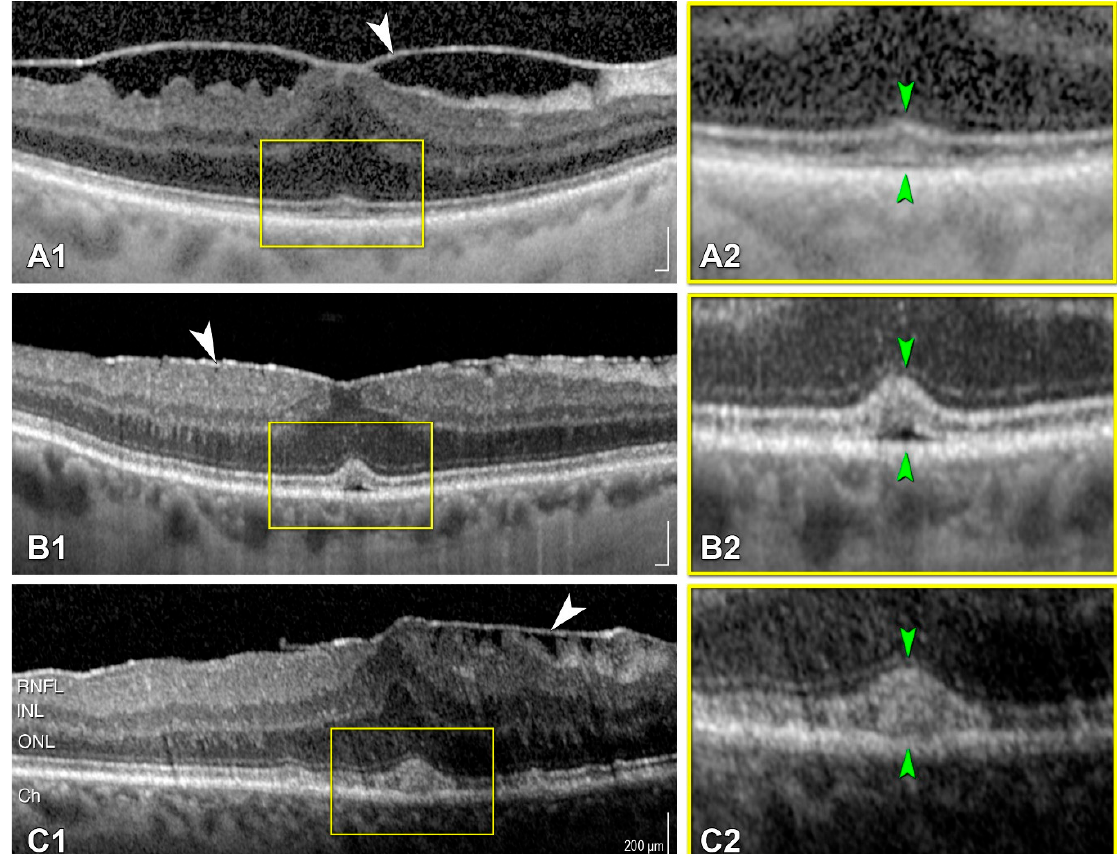
Figure 1. Tractional abnormalities of the central bouquet. Panels ( A1 – C1 ) and the corresponding magnifications (yellow boxes) ( A2 – C2 ) show SD-OCT scans through the fovea the different stages of central bouquet (CB) alterations, as proposed by Govetto et al. [7]. ( A1 , A2 ) Stage 1 CB alteration: a small, fuzzy hyperreflective area (cotton ball sign, green arrowheads), associated with a stage 3 epiretinal membrane (ERM) (white arrowhead). ( B1 , B2 ) Stage 2 CB alteration: a central hypore- flective pocket of subretinal fluid under the interdigitation zone (green arrowheads), associated with a stage 2 ERM (white arrowhead). ( C1 , C2 ) Stage 3 CB alteration: a thick, dome-shaped, hyperreflective, acquired vitelliform lesion between the retinal pigment epithelium and the ellipsoid zone (green arrowheads), associated with a stage 3 ERM (white arrowhead). Scaling is identical in all images. Scale bars are displayed in the bottom right corners of panels ( A1 – C1 ). For improved readability, units are only shown once in panel ( C1 ). CB = central foveal bouquet; ERM = epiretinal membrane; RNFL = retinal nerve fiber layer; INL = inner nuclear layer; ONL = outer nuclear layer; Ch = choroid.